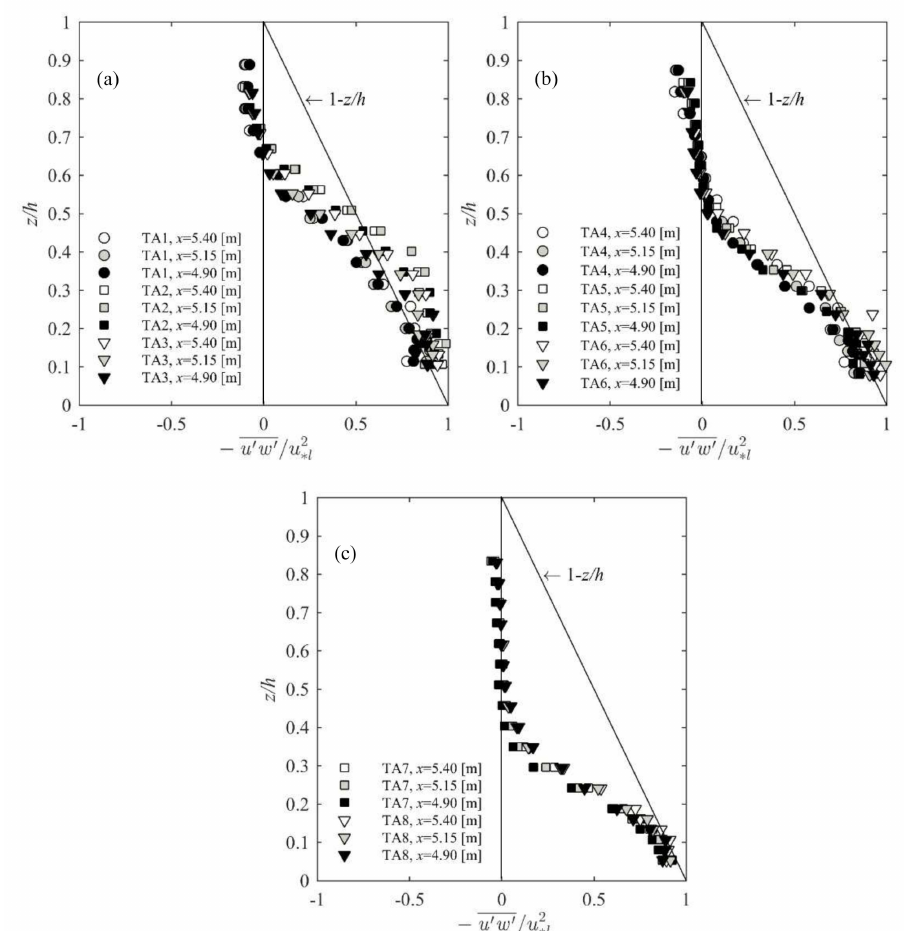
Figure 12. Normalized Reynolds shear stress profiles for ( a ) TA1–TA3, ( b ) TA4–TA6, ( c ) TA7 and TA8 in all cross-sections and universal fit